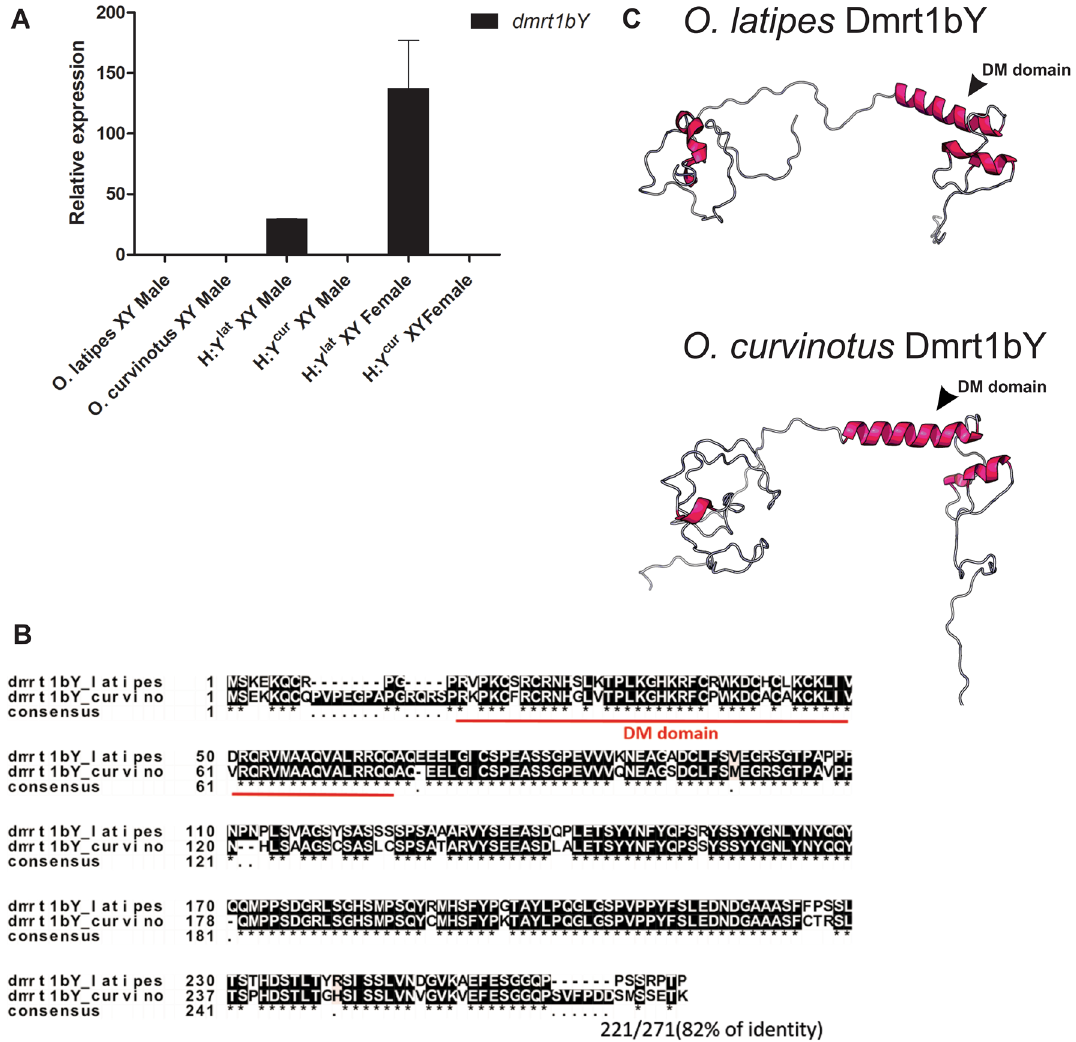
Figure 4. Expression and protein structure analyses of dmrt1bY . ( A ) Normalized read counts for dmrt1bY transcripts in parental and hybrids that contain the Y chromosome. ( B ) Alignment of predicted amino acid sequence of Dmrt1bY for O. latipes and O. curvinotus . The red line shows the DM domain. ( C ) Putative protein of Dmrt1bY for O. latipes and O. curvinotus. The DM domain (in pink) presents the typical zinc-finger-like DNA binding